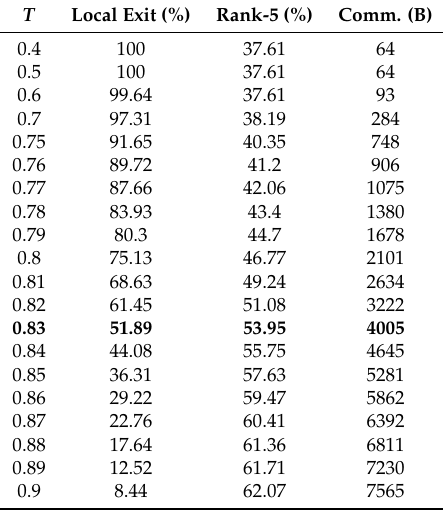
Table 6. While local network L = 19, the effects of different exit threshold ( T ) settings for the local. T = 0.83 is used in L = 19